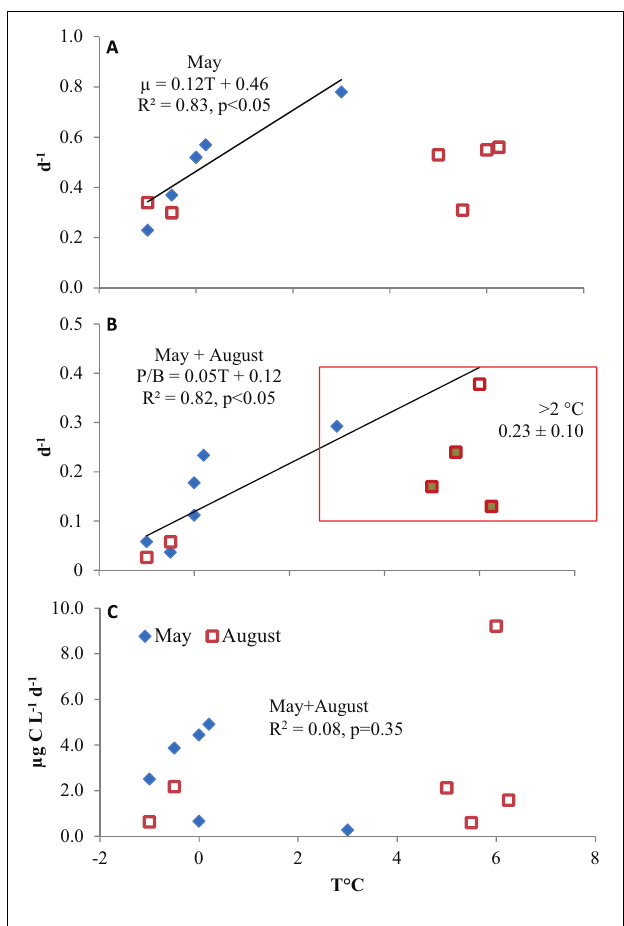
FIGURE 8 | The average growth rates of microzooplankton populations that increased over time in experimental incubations (A) and total microzooplankton growth (B) vs. sea temperature in May (filled triangles) and August (open squares). Filled squares denote regression outliers. (C) Microzooplankton community